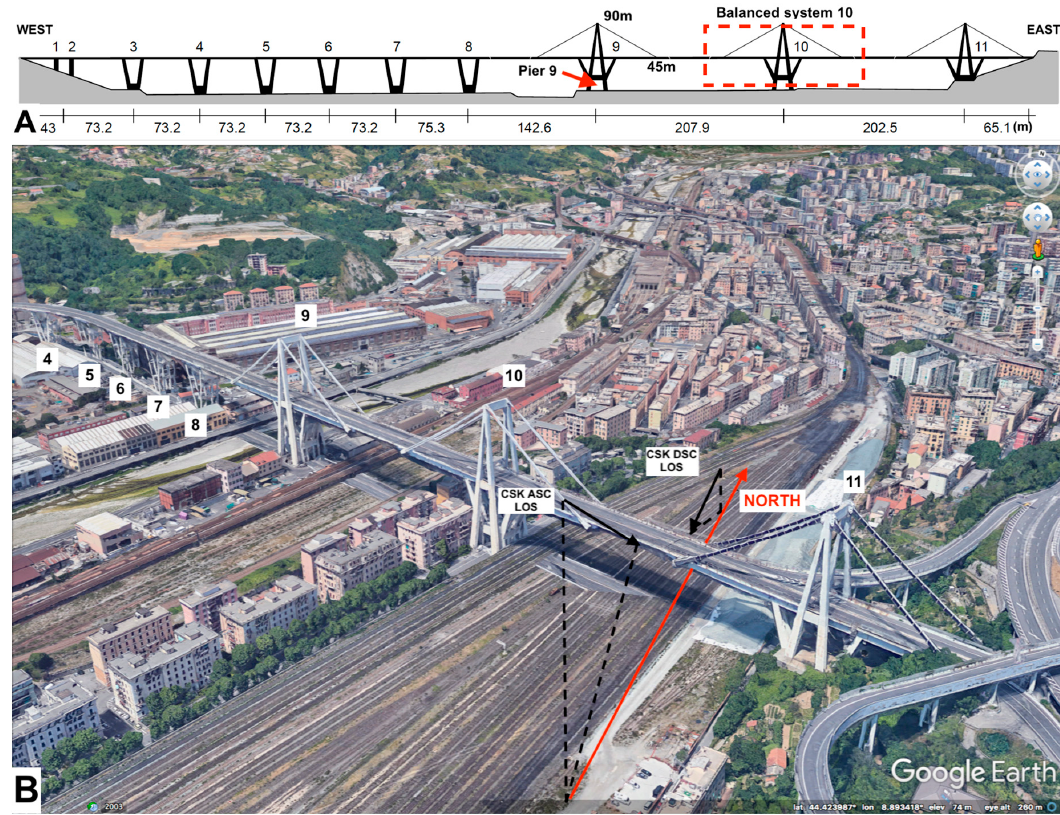
Figure 1. The Morandi bridge before collapse. ( A ) Two-dimensional structural scheme of the bridge. From West to East, the bridge includes two single piers (1 to 2), six V-shaped piers (3 to 8) and three independent balanced systems (9 to 11). Dimensions in meters. ( B ) Three-dimensional view of the bridge.